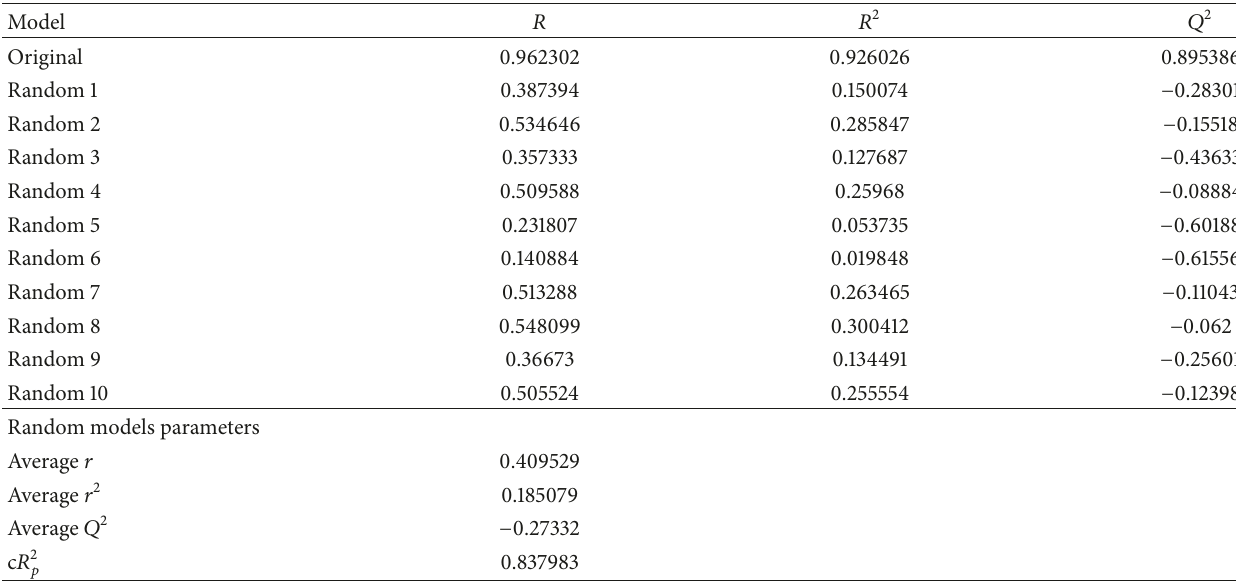
Table 9: 𝑌 - Randomization parameters